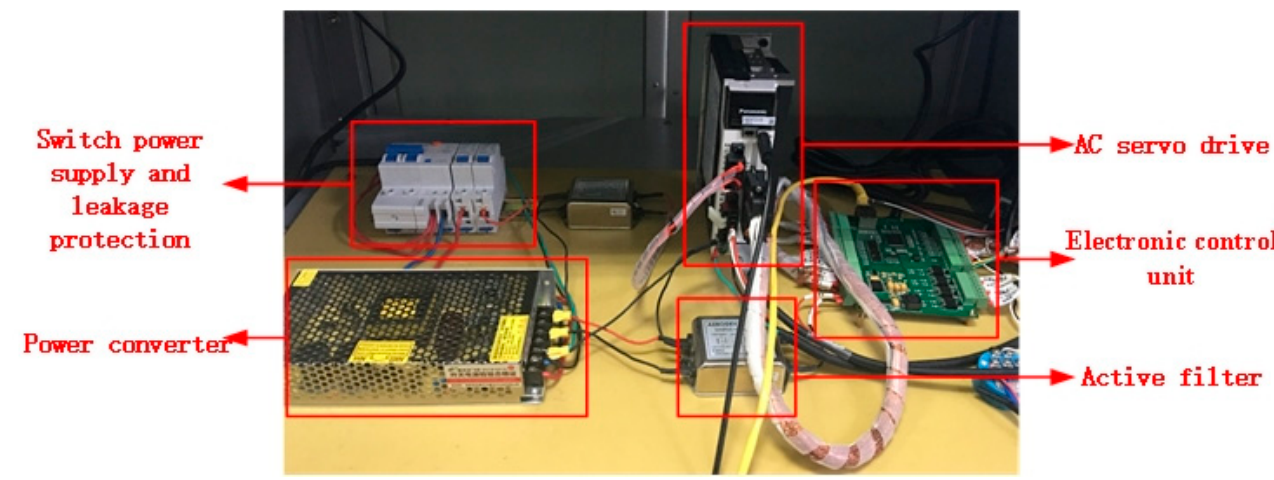
Figure 9. Structure of the experimental facility.